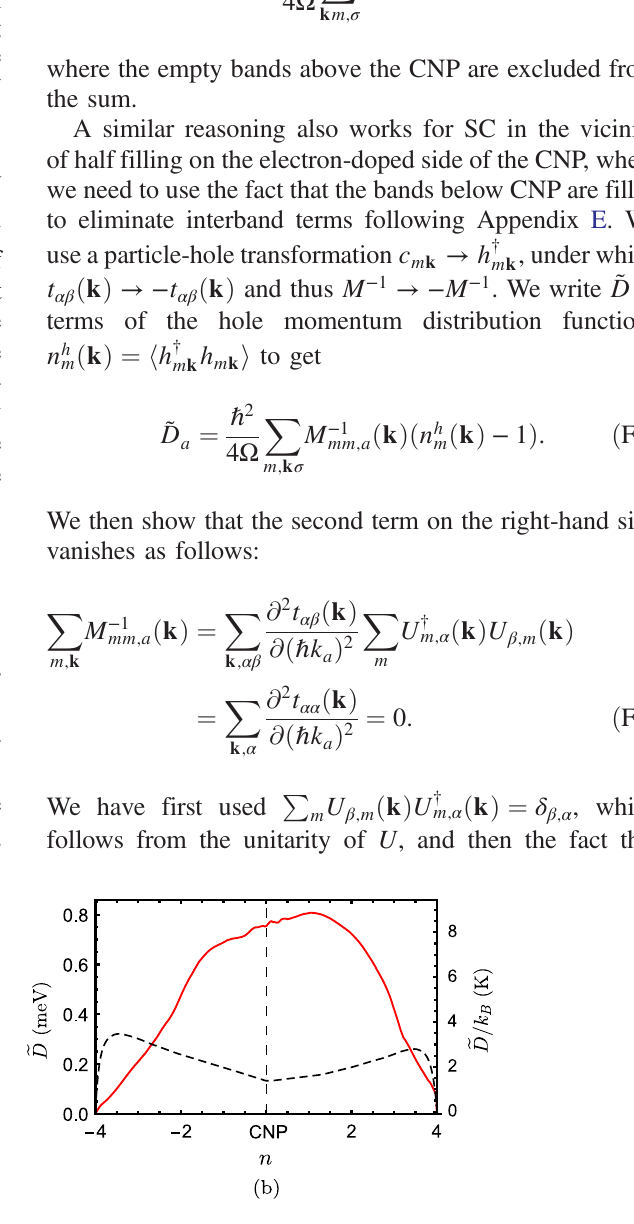
FIG. 4. Comparison of (a) the band structure and (b) the integrated spectral weight Ref. [18] (in